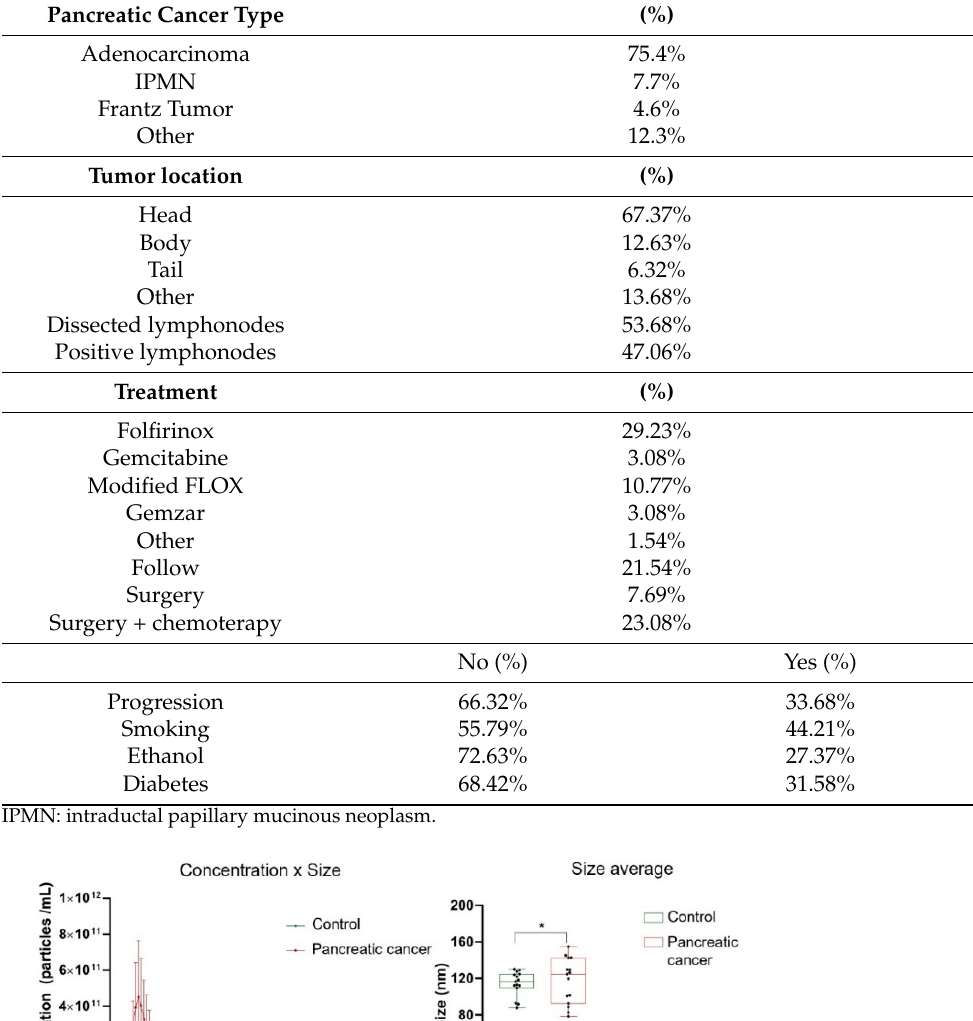
Table 2. Clinical and epidemiological data for pancreatic cancer patients, according to cancer type, tumor location, tumor progression, tobacco and alcohol usage, diabetes, and treatment.